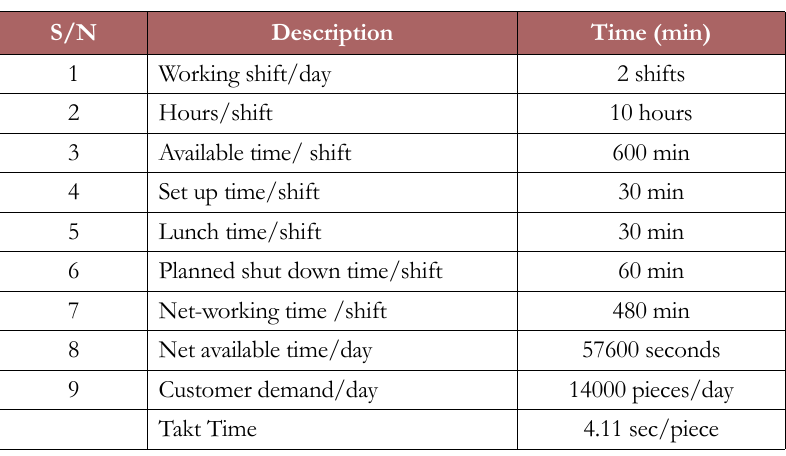
Table 3. Present Takt time of AB Paper Production line